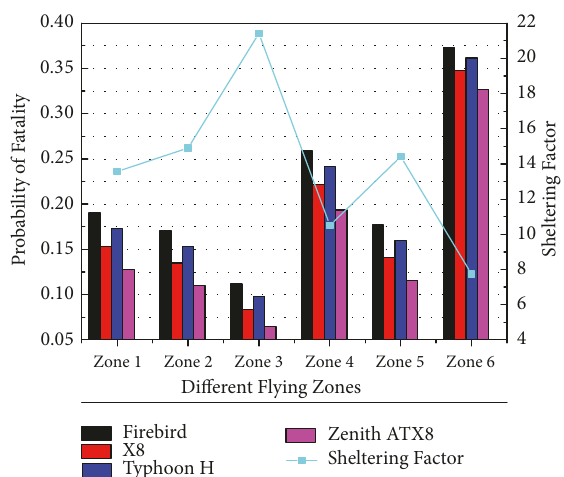
Figure 8: Probability of fatality and sheltering factor in different flying zones.